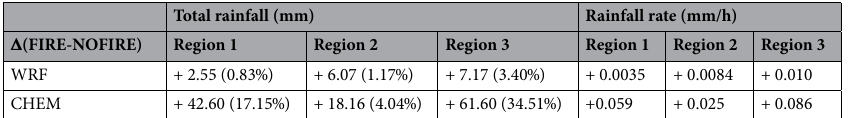
Table 1. Differences (FIRE-NOFIRE) in monthly total surface rainfall (mm) and monthly mean rainfall rates (mm/h) averaged over each region. The changes in percentages are in comparison to the monthly mean values in NOFIRE, and the same percentage applies to both total rainfall and rainfall rate in the same